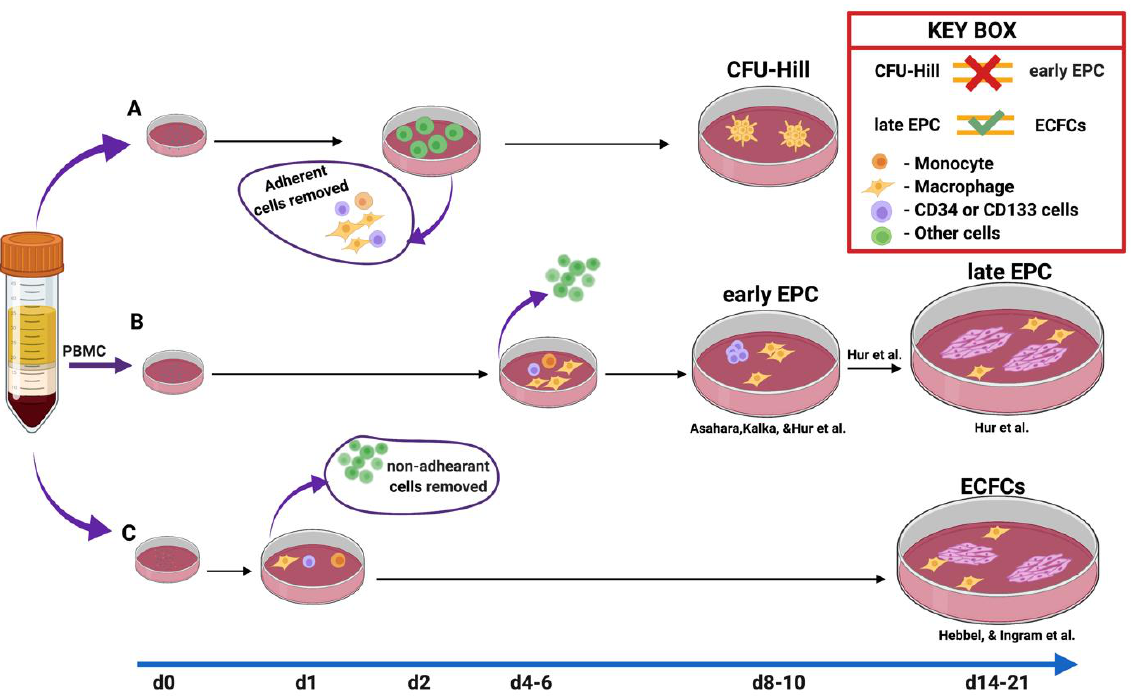
Figure 1. The methods of EPC culture. Method A is the colony-forming units of Hill. In this method, the adherent cells were depleted at day 2/48 h due to the author’s concern regarding contamination